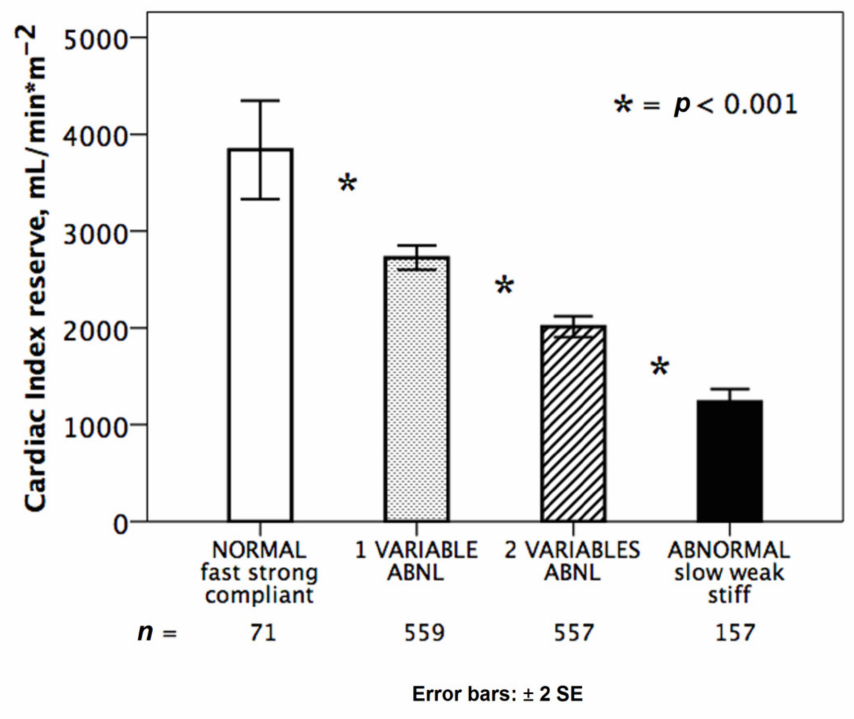
Figure 1. Normal and abnormal hemodynamic responses during stress. Cardiac index reserve in normal response (white bar, n = 71): fully abnormal hearts (black bar, n = 157) with reduced chronotropic, preload and contractile reserve; partially abnormal responses with one (dotted bar: stiff, n = 322; weak, n = 170; slow, n = 66) or two abnormalities (dashed bar: weak + slow, n = 229; stiff + slow, n = 178; stiff + weak, n = 151). * = p < 0.001 across various